Question: What does this figure show? Answer in one sentence.
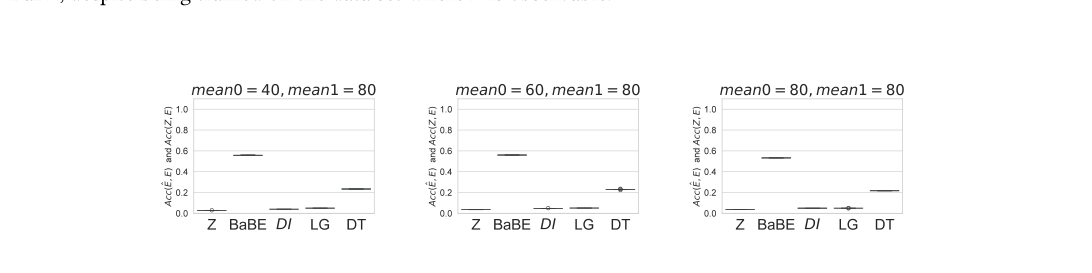
Answer: Experiments on the synthetic data sets: The accuracy between 𝑍and 𝐸, and between ˆ𝐸and 𝐸.